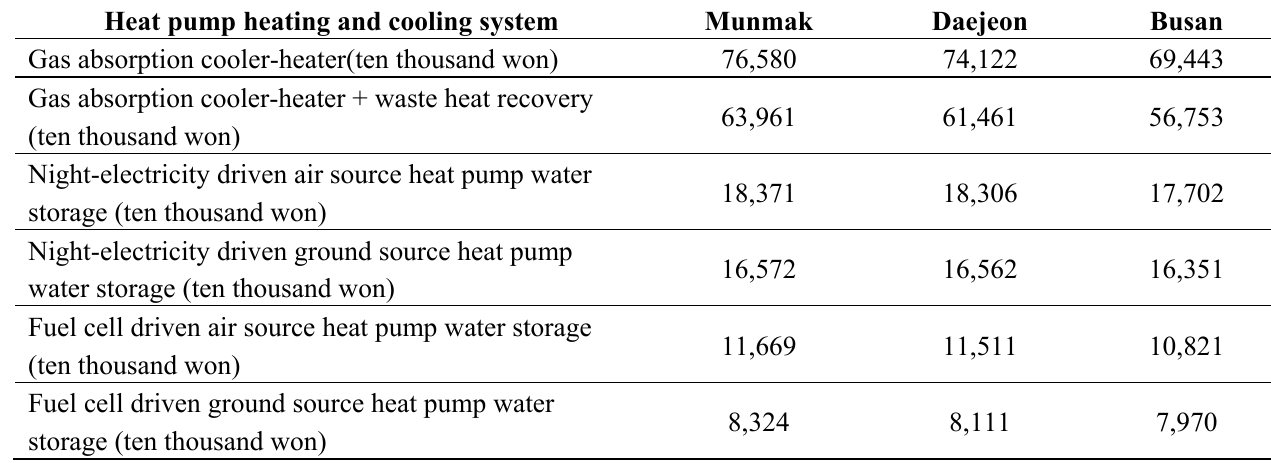
Table 7. Comparison of operation